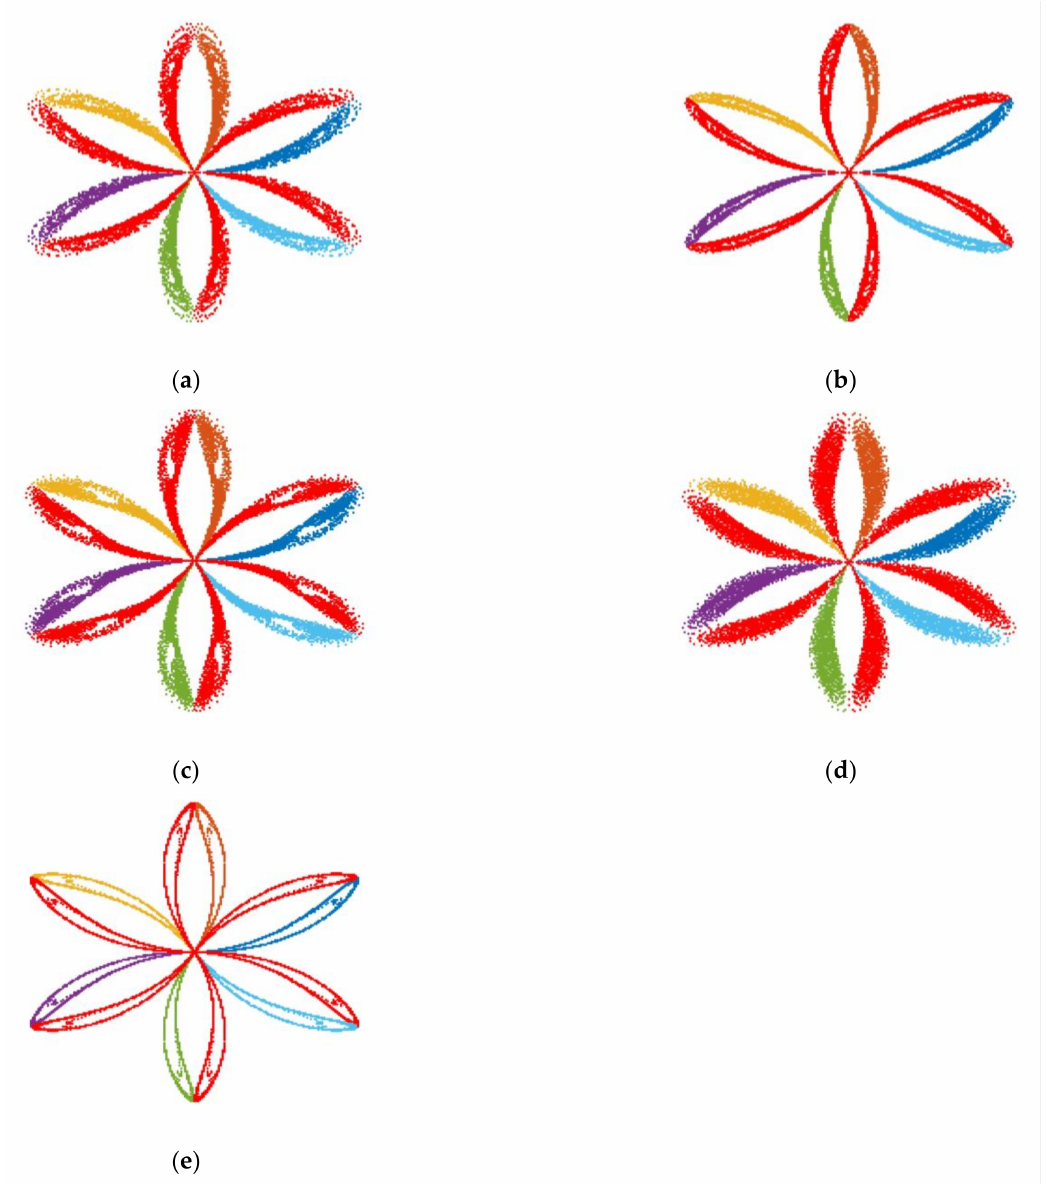
Figure 14. The snowflake images under different conditions: ( a ) Nor, ( b ) BBLF, ( c ) MF, ( d ) IF, ( e )